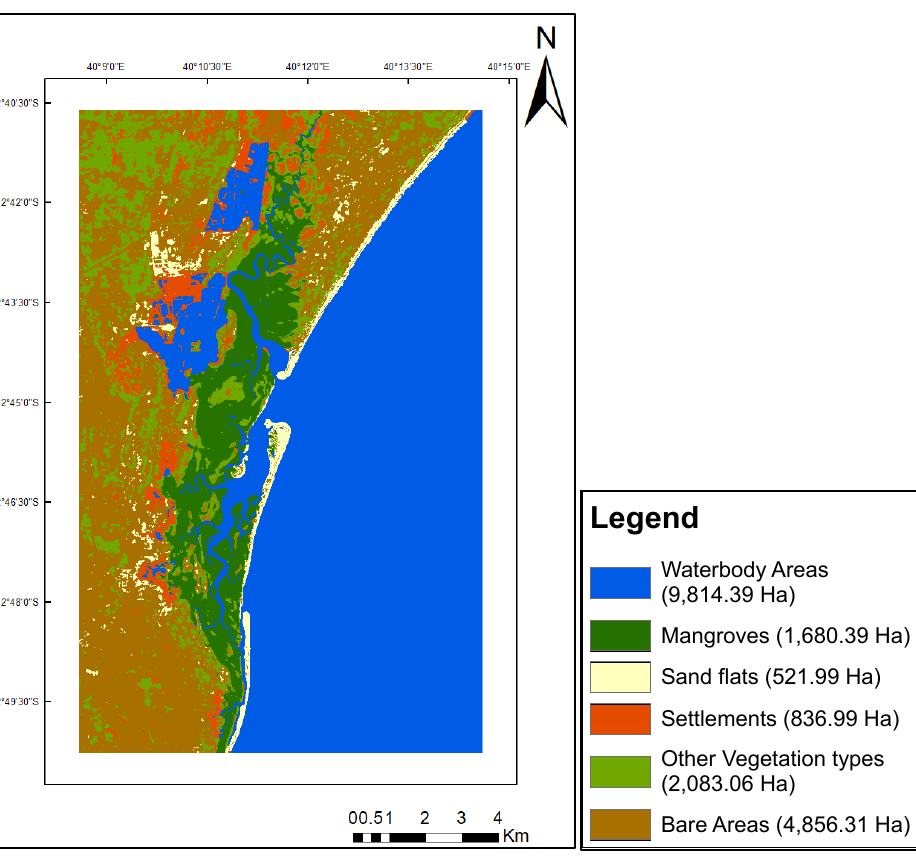
Figure 2. LULC classes and the area (Ha) of each class present in Mto-Kilifi (Ungwana bay, Kenya) were processed using Sentinel-2 satellite image sensed in February